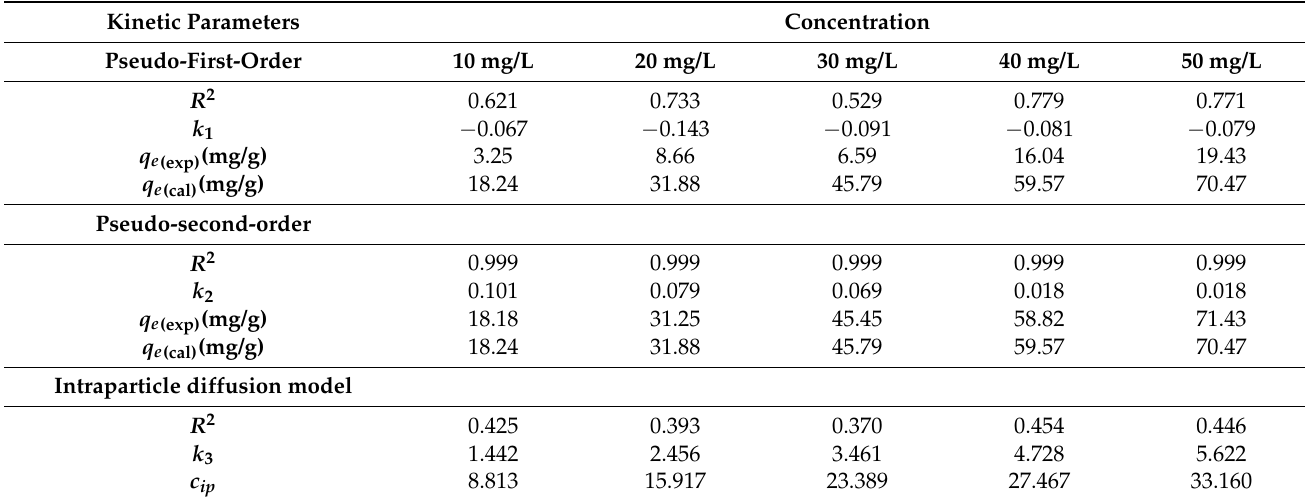
Table 1. Kinetic parameters of pseudo-first-order, pseudo-second-order and intraparticle diffusion models for the adsorption of LVX using the rGO-WO 3